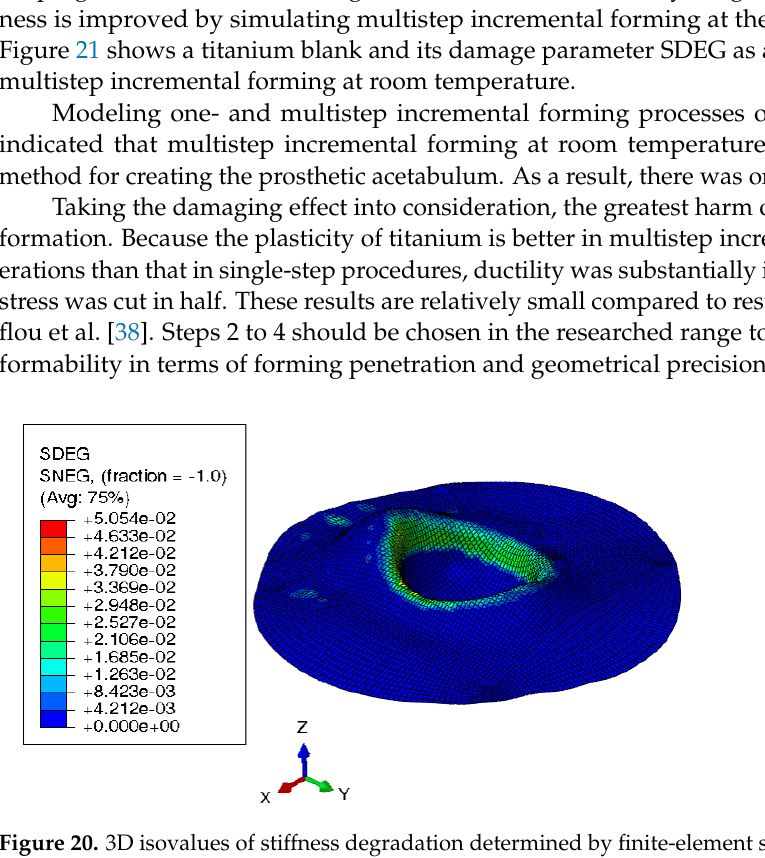
Figure 20. 3D isovalues of stiffness degradation determined by finite-element simulation for interme- diate step